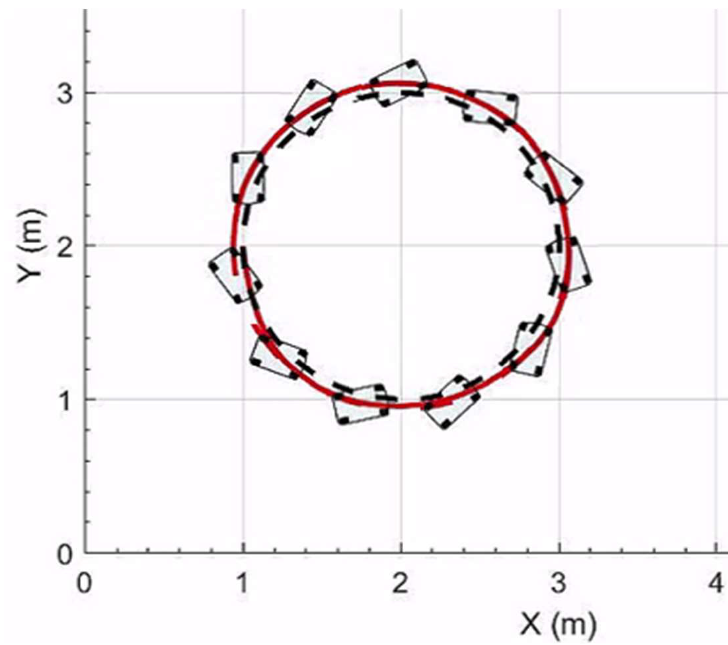
Figure 18. Vehicle states during a drift maneuver (solid blue lines). The desired equilibrium points (dotted red lines) are plotted for reference.